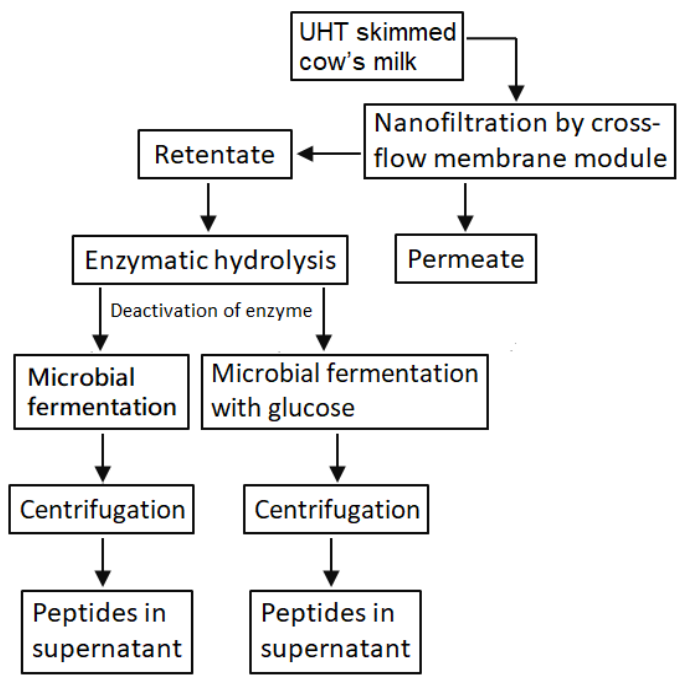
Figure 1. Experimental scheme to prepare peptides with antioxidant capacity, angiotensin-converting enzyme inhibitory activity, antibacterial activity and hypoallergenic properties from skimmed UHT cow’s milk.